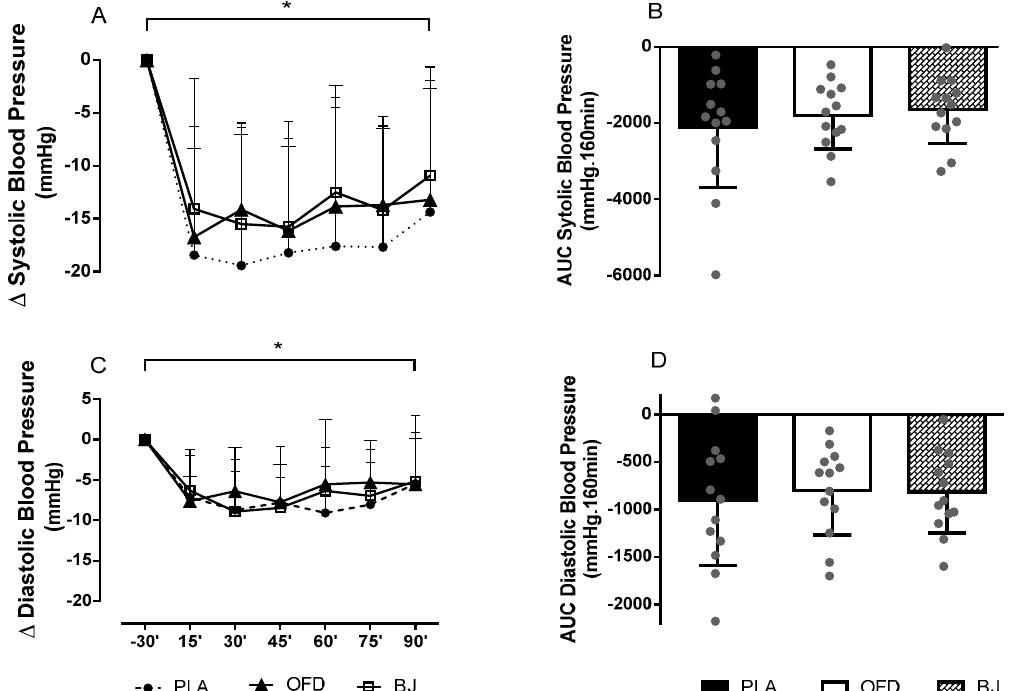
Figure 4. ∆ values for systolic blood pressure variation ( A ) and diastolic blood pressure variation ( C ), area under the curve (AUC) for systolic blood pressure ( B ) and for diastolic blood pressure ( D ). Placebo NO 3 − depleted beetroot juice (PLA); Non-caloric orange flavor drink (OFD); Beetroot juice (BJ). The negative time values refer to measurements before exercise. The positive time values refer to measurements after the exercise. (*) significantly different when compared to the − 30’ point (pre-exercise).